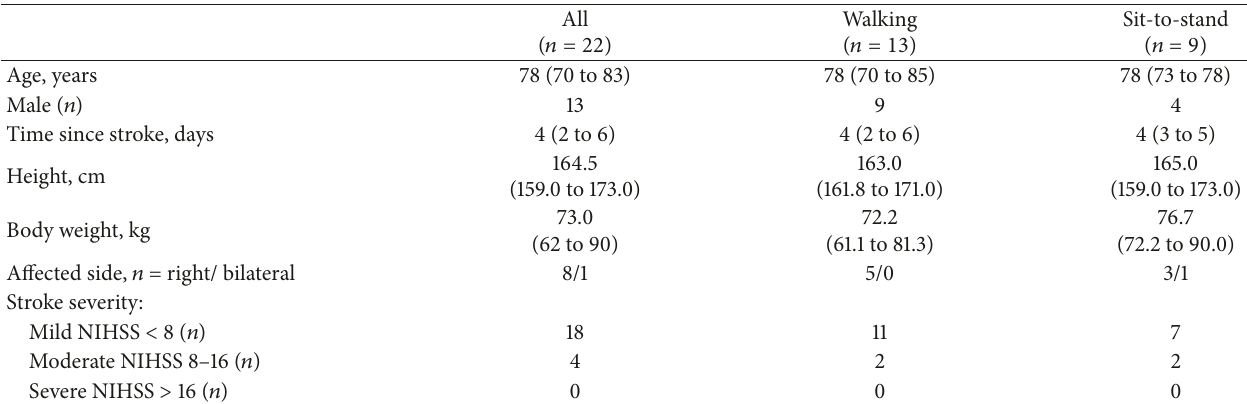
Figure 1: Flowchart of datasets for metabolic cart and SWA available for analyses. Table 1: Participant